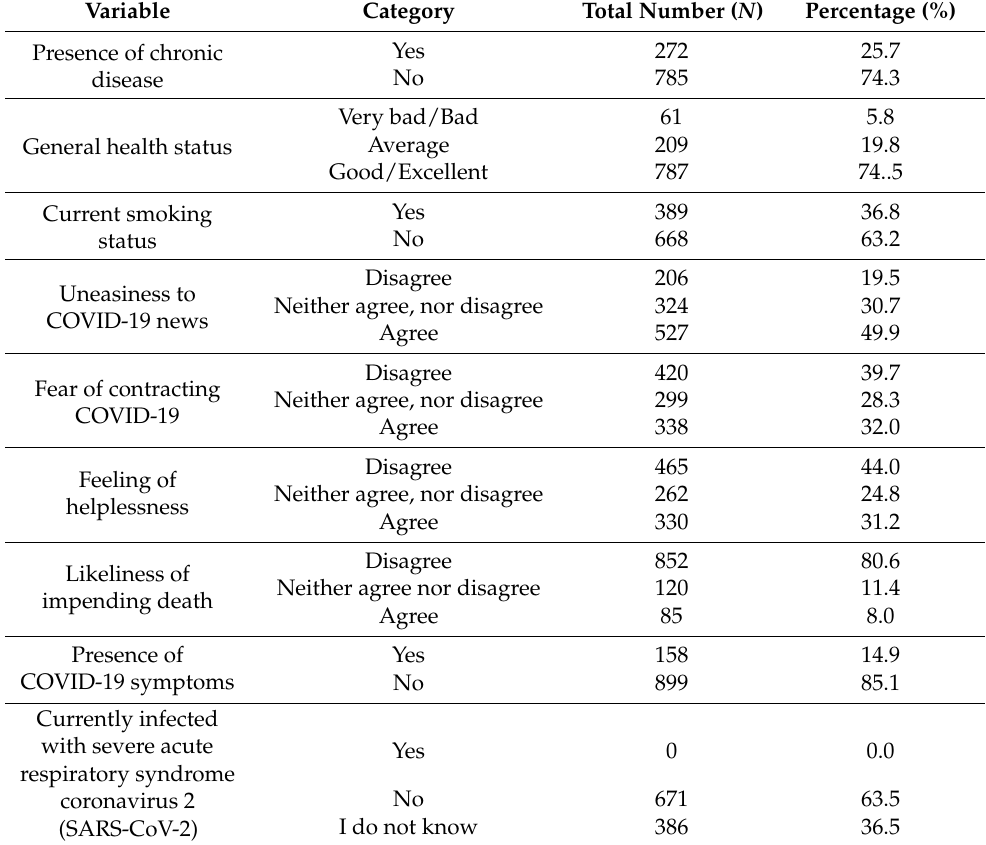
Table 2. Self-estimated general health status and coronavirus disease 2019 (COVID-19) psychologi- cal